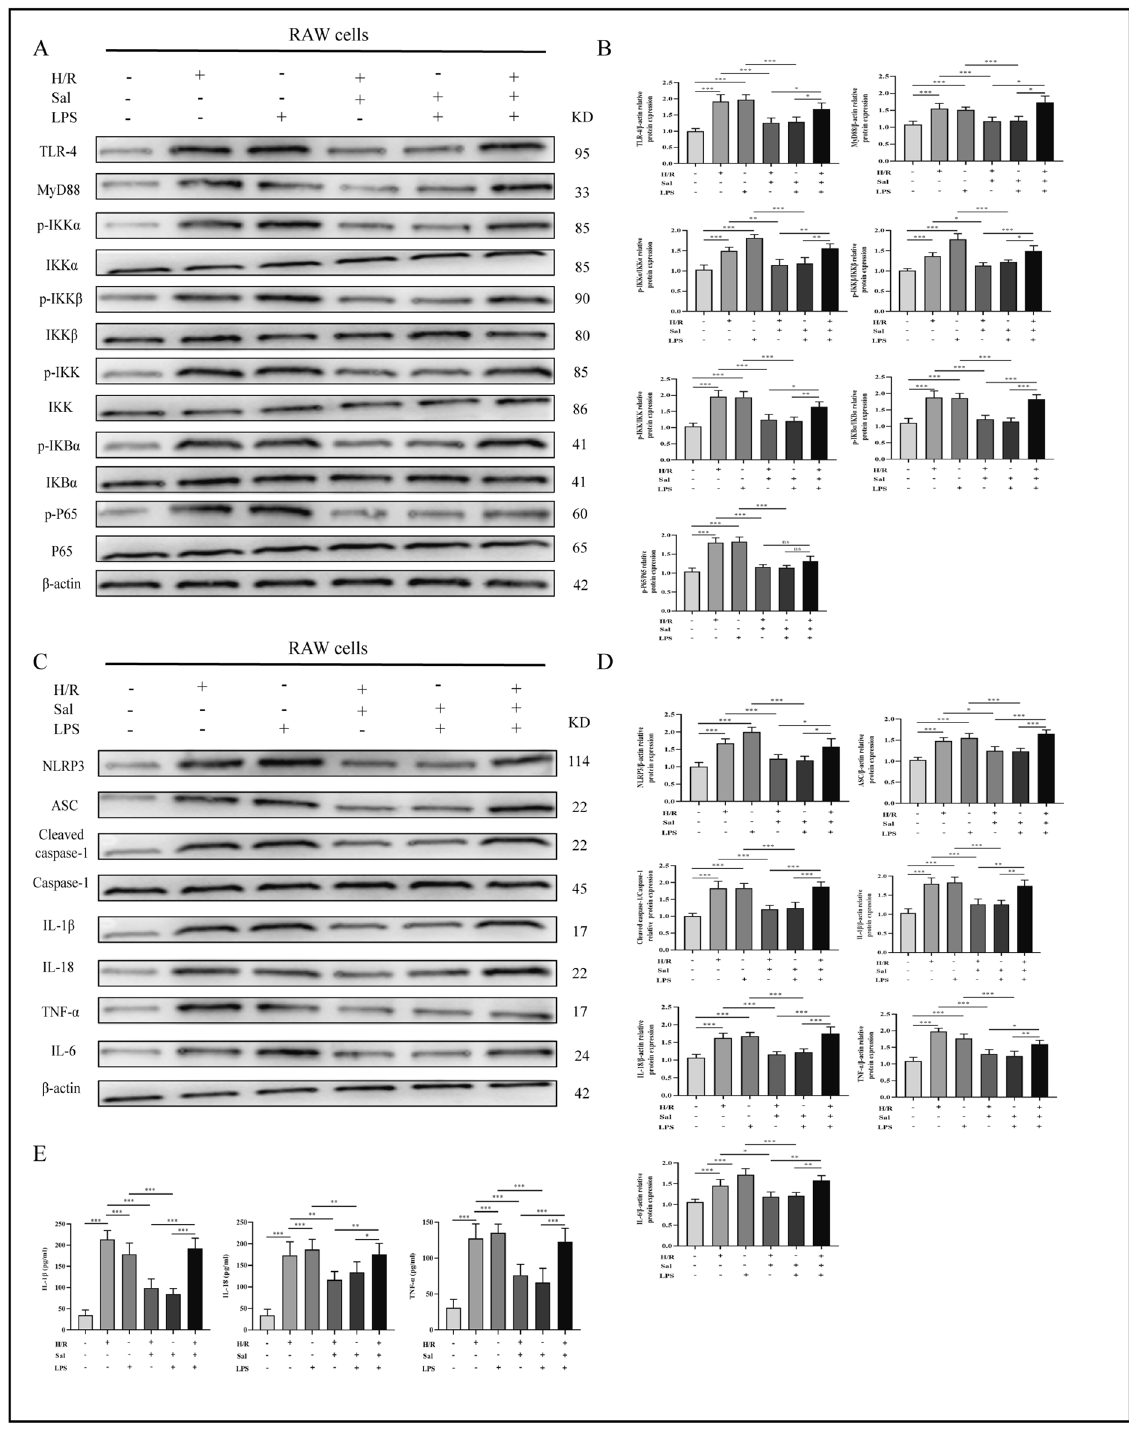
Figure 6. LPS (TLR-4 activator) partially alleviates the anti-inflammatory ability of salidroside via regulation of the TLR-4/NF-κB/NLRP3 inflammatory pathway. ( A , C ) Representative Western blot data of the TLR-4/ NF-κB/NLRP3 inflammatory pathway associated proteins in macrophages. ( B , D ) The results of western blot experiments. ( E ) Production of IL-1β, IL-18 and TNF-α in macrophages was assessed by ELISA. The statistical differences among groups were assessed by one-way ANOVA. ns P > 0.05, * P < 0.05, ** P < 0.01, *** P <